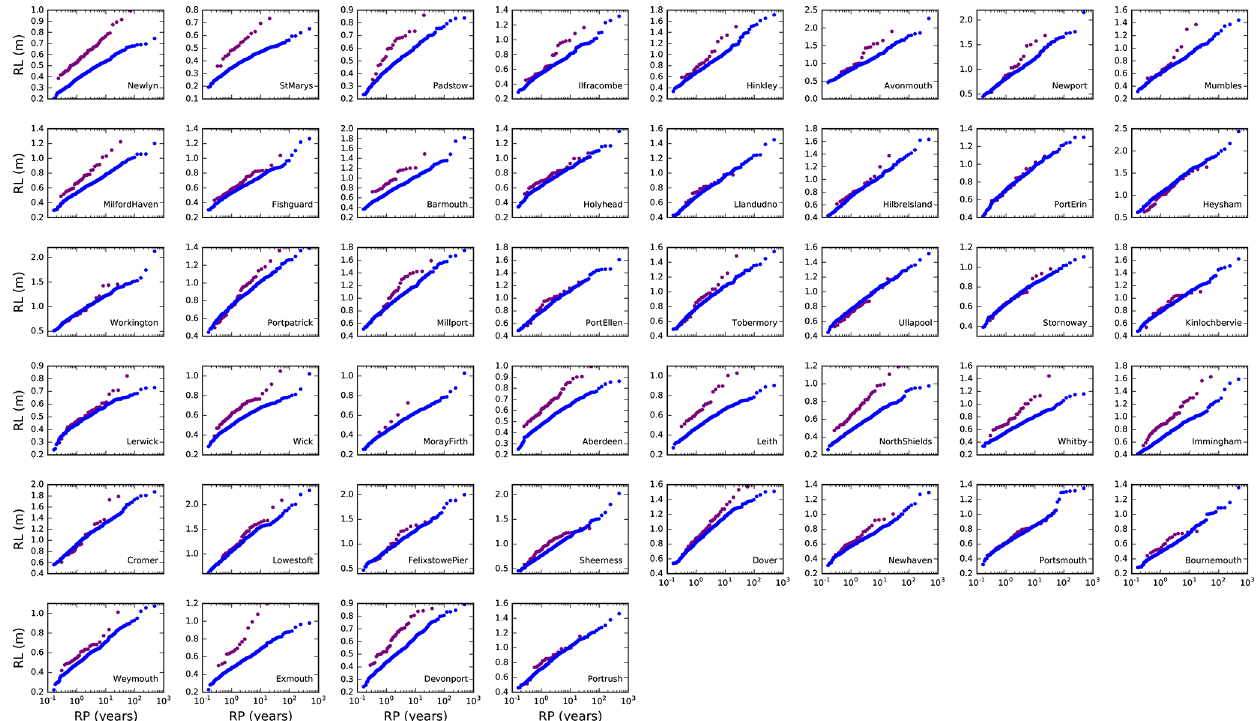
Figure B1. Empirical return level plots for 44 UK tide gauges. Purple shows observational (tide gauge) data. Blue shows data from the 483-year HadGEM3-GC3-MM